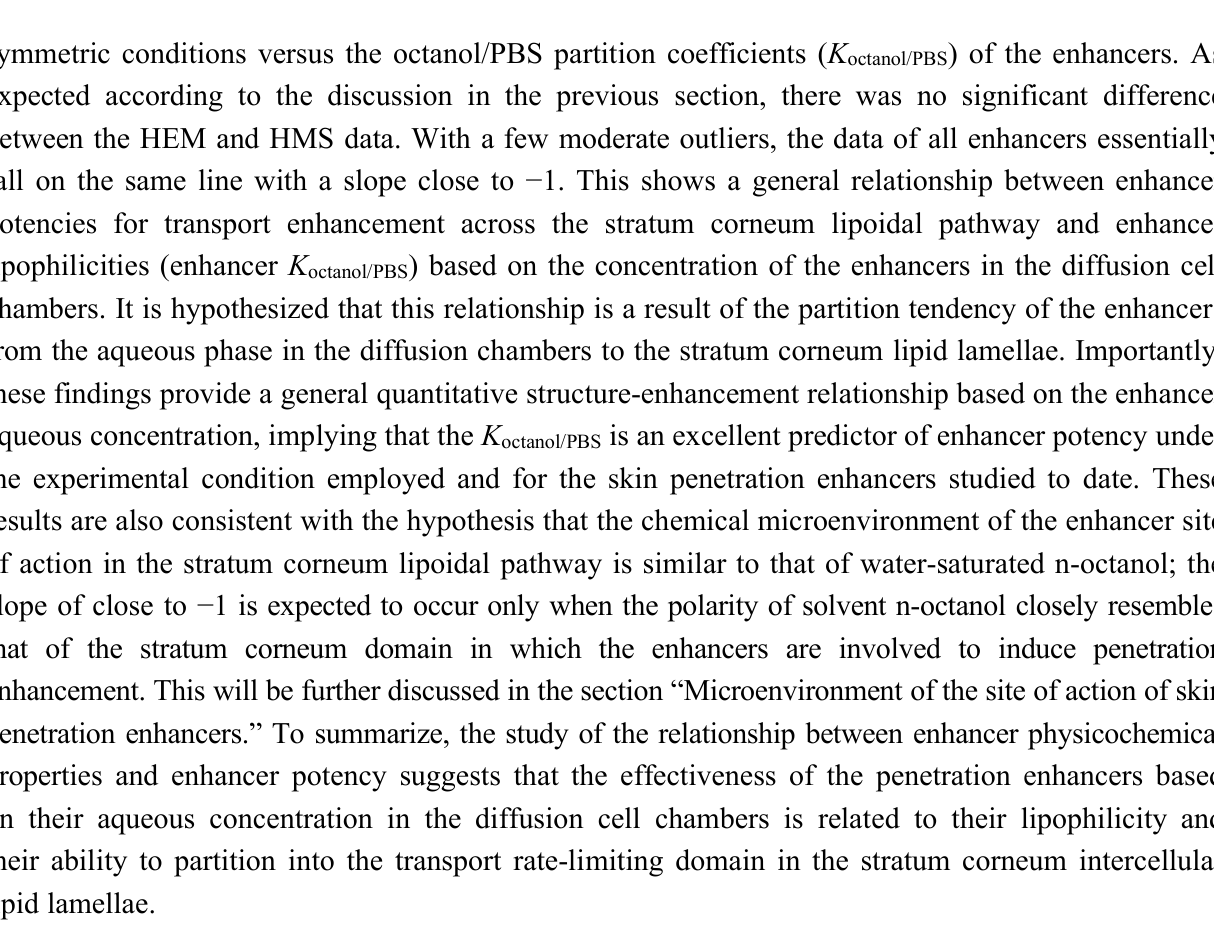
Figure 4. Relationship between the aqueous concentrations of the enhancers to induce 10-fold penetration enhancement and enhancer K (octanol/PBS partition coefficient). octanol/PBS The data are taken from previous hairless mouse skin (HMS) and human epidermal membrane (HEM) studies [6,22–27,30,31]. PBS = phosphate buffered